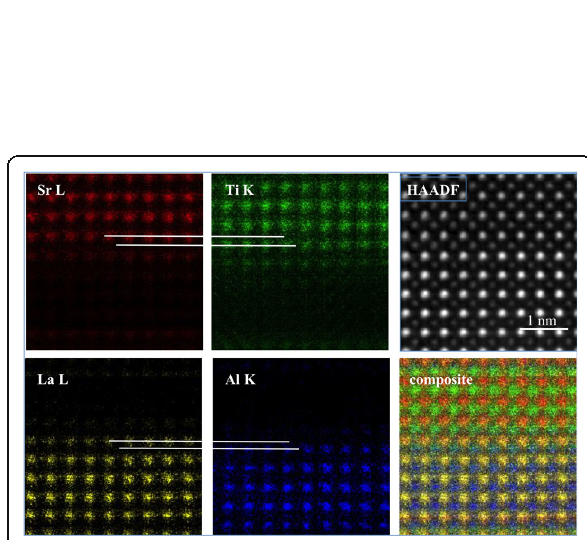
Fig. 10 EDX images of a near-atomically abrupt SrTiO 3 /LaAlO 3 interface showing atomic columns identified as labeled, with 10 min total acquisition using an Oxford X-Max 100TLE detector on a JEOL ARM200 equipped with ASCOR aberration corrector operated at 200 kV. The composite image includes all edges except O, top right is the HAADF image. Data courtesy Mengsha